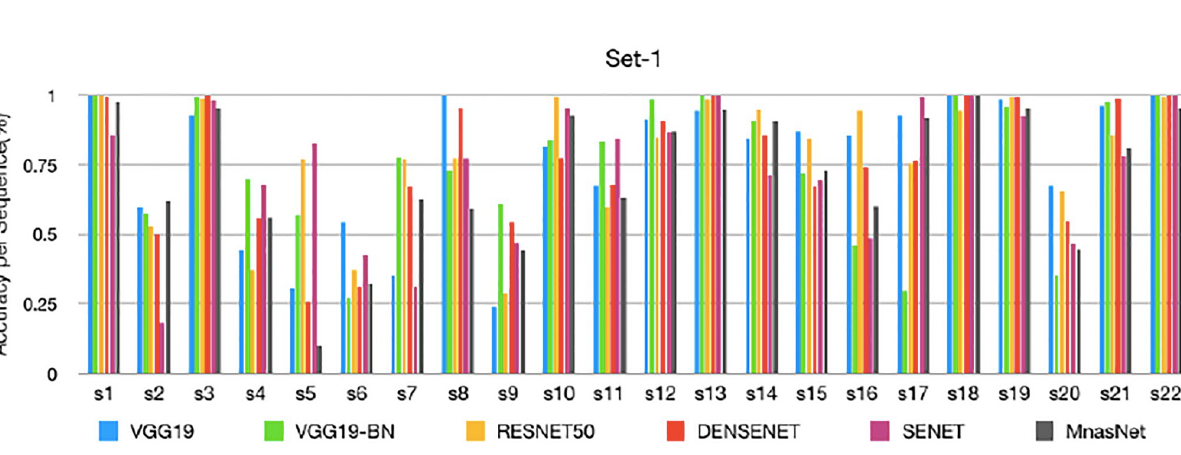
PLOS ONE | https://doi.org/10.1371/journal.pone.0236452 July 30,